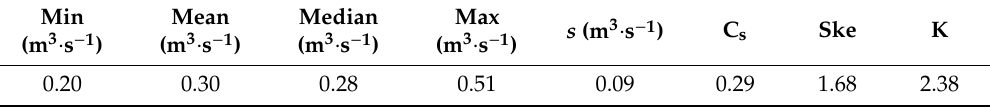
Table 4. Values of descriptive statistics for the low flows time series in the period 2002–2017.